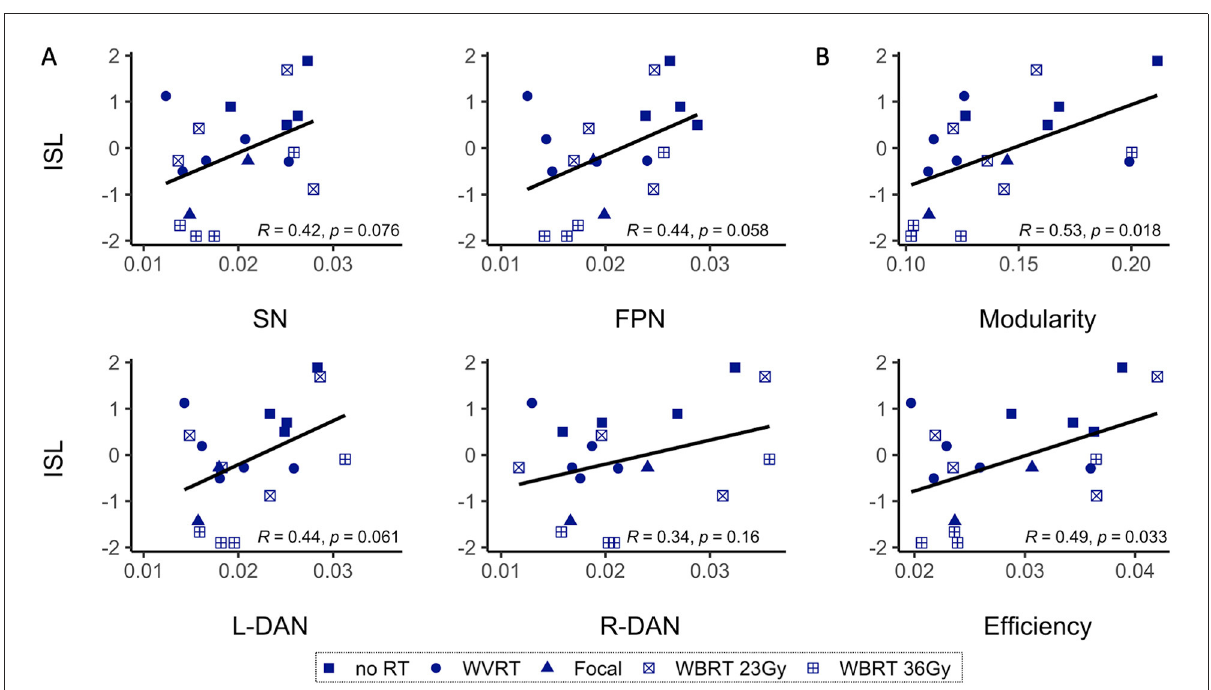
FIGURE5 Age-normalized MR metrics and ISL test scores are correlated. Age-normalized network variability (A) and functional connectivity (B) metrics show a positive correlative trend with the age-normalized International Shopping List (ISL) test scores, representative of neurocognitive memory performance. As shown in B, only modularity and efficiency are significantly correlated with ISL. SN, salience network; FPN, frontoparietal network; L-DAN, left hemisphere dorsal attention network; R-DAN, right hemisphere DAN.